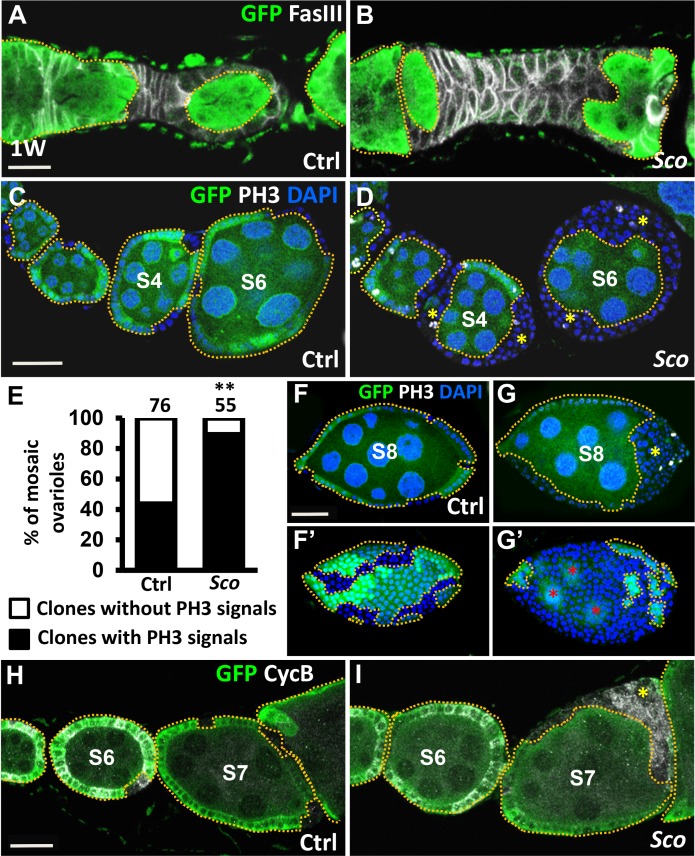
Sco follicle cells are hyperproliferative and do not enter the endocycle.Control (Ctrl) (A, C, F and H) and Sco mosaic ovarioles (B, D, G and I) at one week (1W) after clone induction (ACI) are labeled with GFP (green, wild-type cells) and FasIII (gray, membranes of follicle cell lineages) in A and B, phospho-Histone 3 (PH3, gray, mitotic marker) and DAPI (blue, DNA) in C, D, F and G, and Cyclin B (CycB, gray, G2/M phase marker) in H and I. Wild-type cells are outlined by yellow dashed lines. The scale bar in A is 10 μm, and scale bars in C, F and H are 20 μm. (A and B) Sco mosaic ovarioles contain stalk cell overgrowths that are completely composed of excessive numbers of irregularly-shaped Sco cells, as compared to the control. (C and D) Sco follicle cells formed multiple layers in stage (S) 4 and 6 egg chambers. (E) Percentage (%) of mosaic ovarioles exhibiting PH3 signal in GFP-negative follicle cell clones. The number of ovarioles analyzed is shown above each bar. (F and G) Sco follicle cells of the stage 8 egg chamber formed multiple layers, and continued to undergo mitosis. F’ and G’ show the outermost layers of egg chambers. Asterisks indicate nurse cells. (H and I) Sco follicle cells of the stage 7 egg chamber retained greater CycB signals than the controls. Wild-type cells are outlined by yellow dashed lines. Asterisks indicate anterior or posterior poles of egg chambers. The genotype of the controls in A, C, E, F and H is hs-flp/+; ubi-gfpFRT40A/ FRT40A, and of the Sco mosaic mutant in B, D, E, G and I is hs-flp/+; ubi-gfpFRT40A/ScoFRT40A.